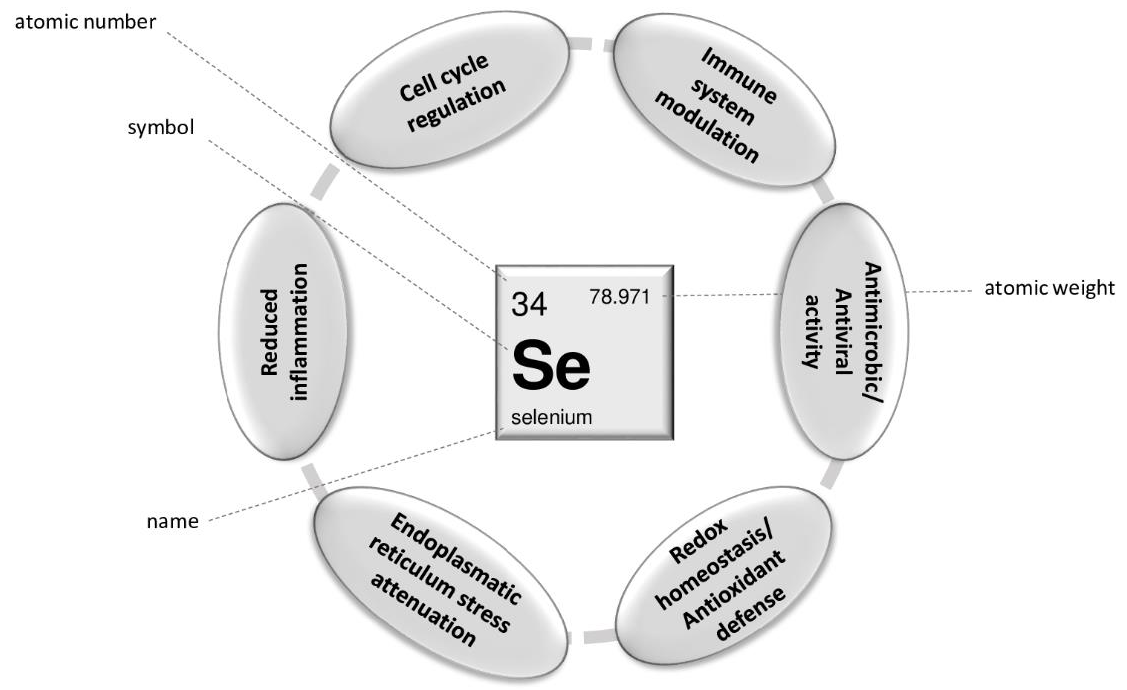
Figure 2. Major pathways modulated by